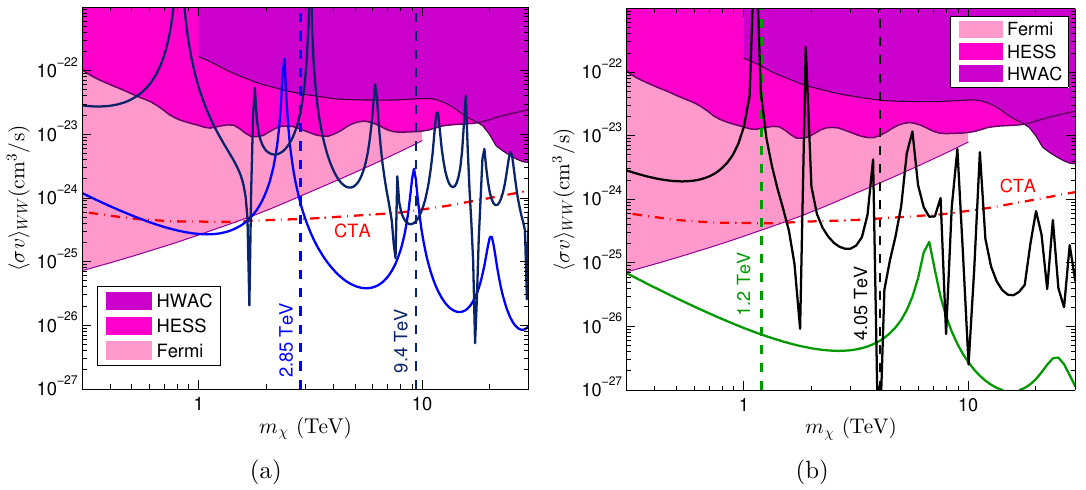
Figure 10. Constraints on annihilation cross-section into W + W − channel for the real represen- tations of EWDM namely triplet (blue) and quintet (navy) on the left (10(a)); as well as the pseudo-real models doublet (green) and quartet (black) on the right (10(a)) from dwarf satellite galaxies obtained by Fermi [108], HESS [109] and HAWC [110] collaborations. CTA sensitivity towards the ultra-faint dSph Segue 1 is shown by red dash-dot line [107]. The shaded area is excluded by the respective experiments. Dashed vertical lines correspond to the thermal mass of each